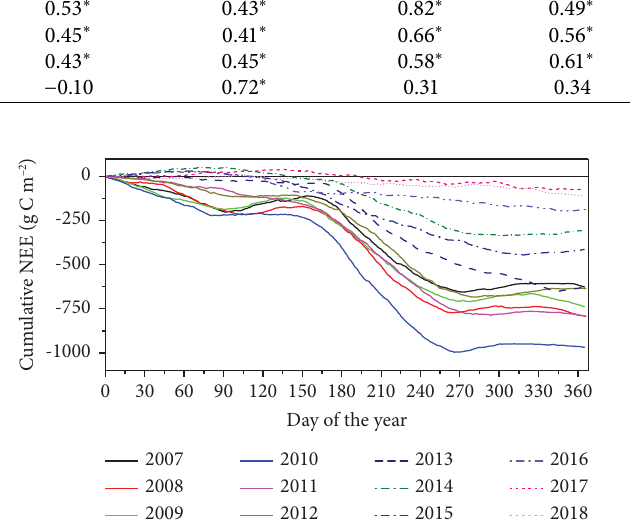
Table 5: Similar to Table 4, the fux variable is the latent heat fux (LE), and the environmental variables include the WS, Rn, Ta, PPT, NDVI, as well as the vapor pressure defcit (VPD), and the WS multiplied by VPD (WS ∗ VPD) at 4m height. Timescales